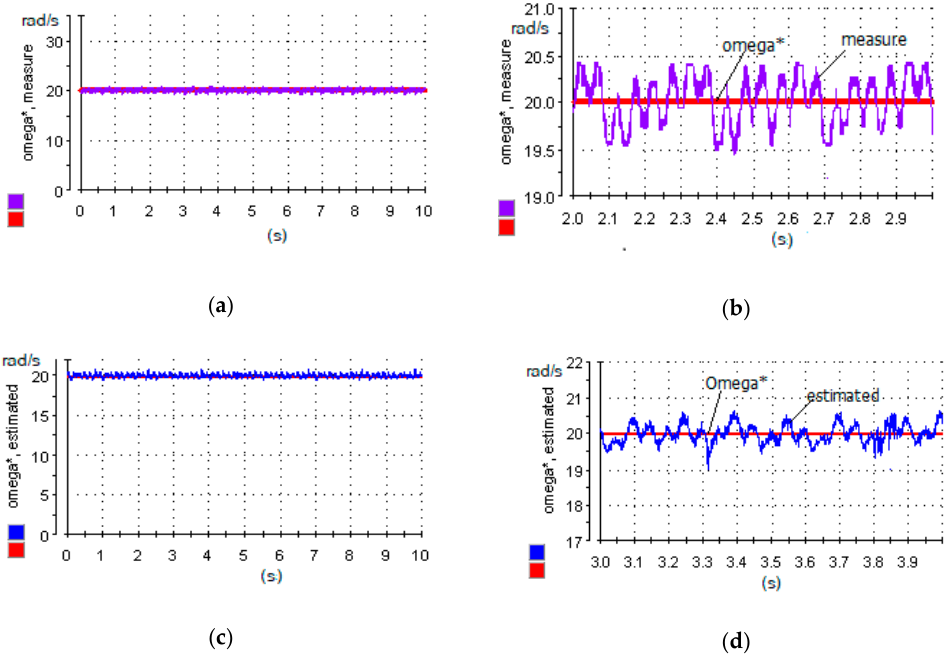
Figure 13. Speed of induction motor without online rotor and stator resistance estimation: ( a , b ) Reference speed and measurement speed; ( c , d ) Reference speed and estimated speed.